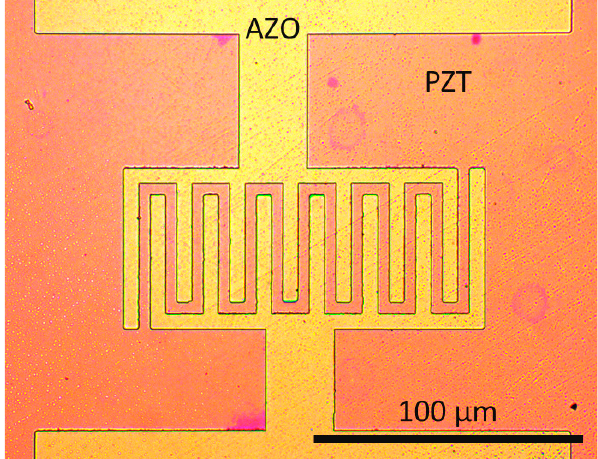
Figure 3. Top-view optical micrograph of a final device showing patterned AZO IDE top electrodes. Here, the gap between subsequent fingers is 5 μm, and each finger is 5-μm-wide.